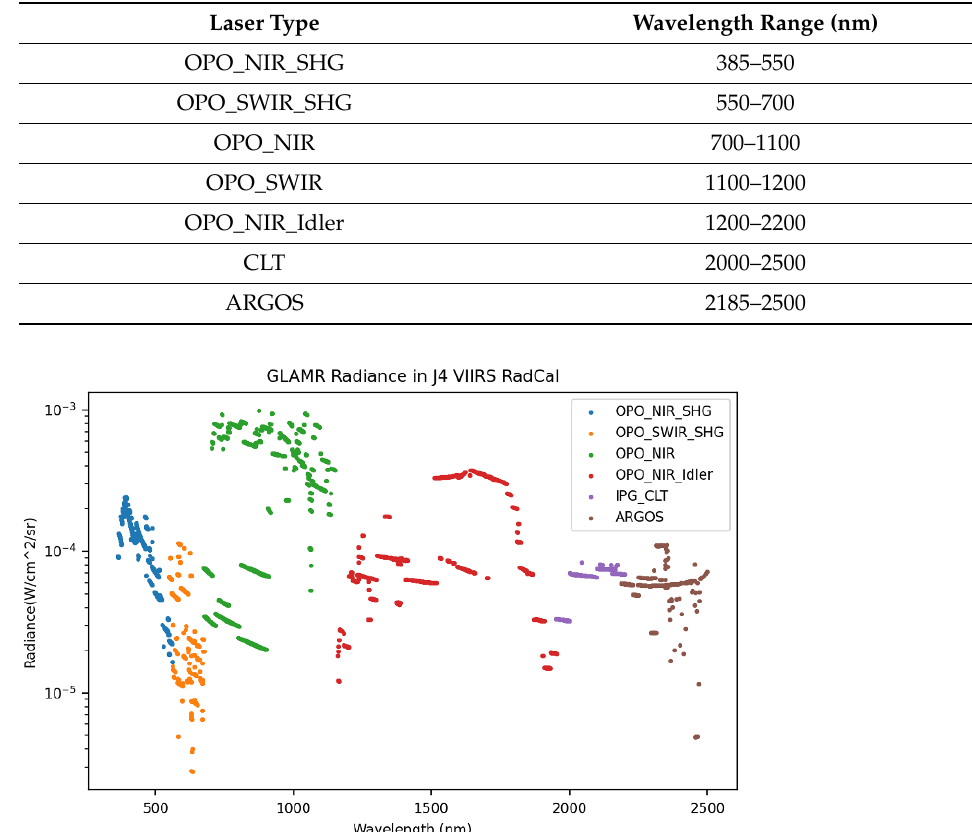
Figure 1. The spectral coverage of GLAMR with its several tunable laser sources. Table 1. Spectral coverage of GLAMR lasers.